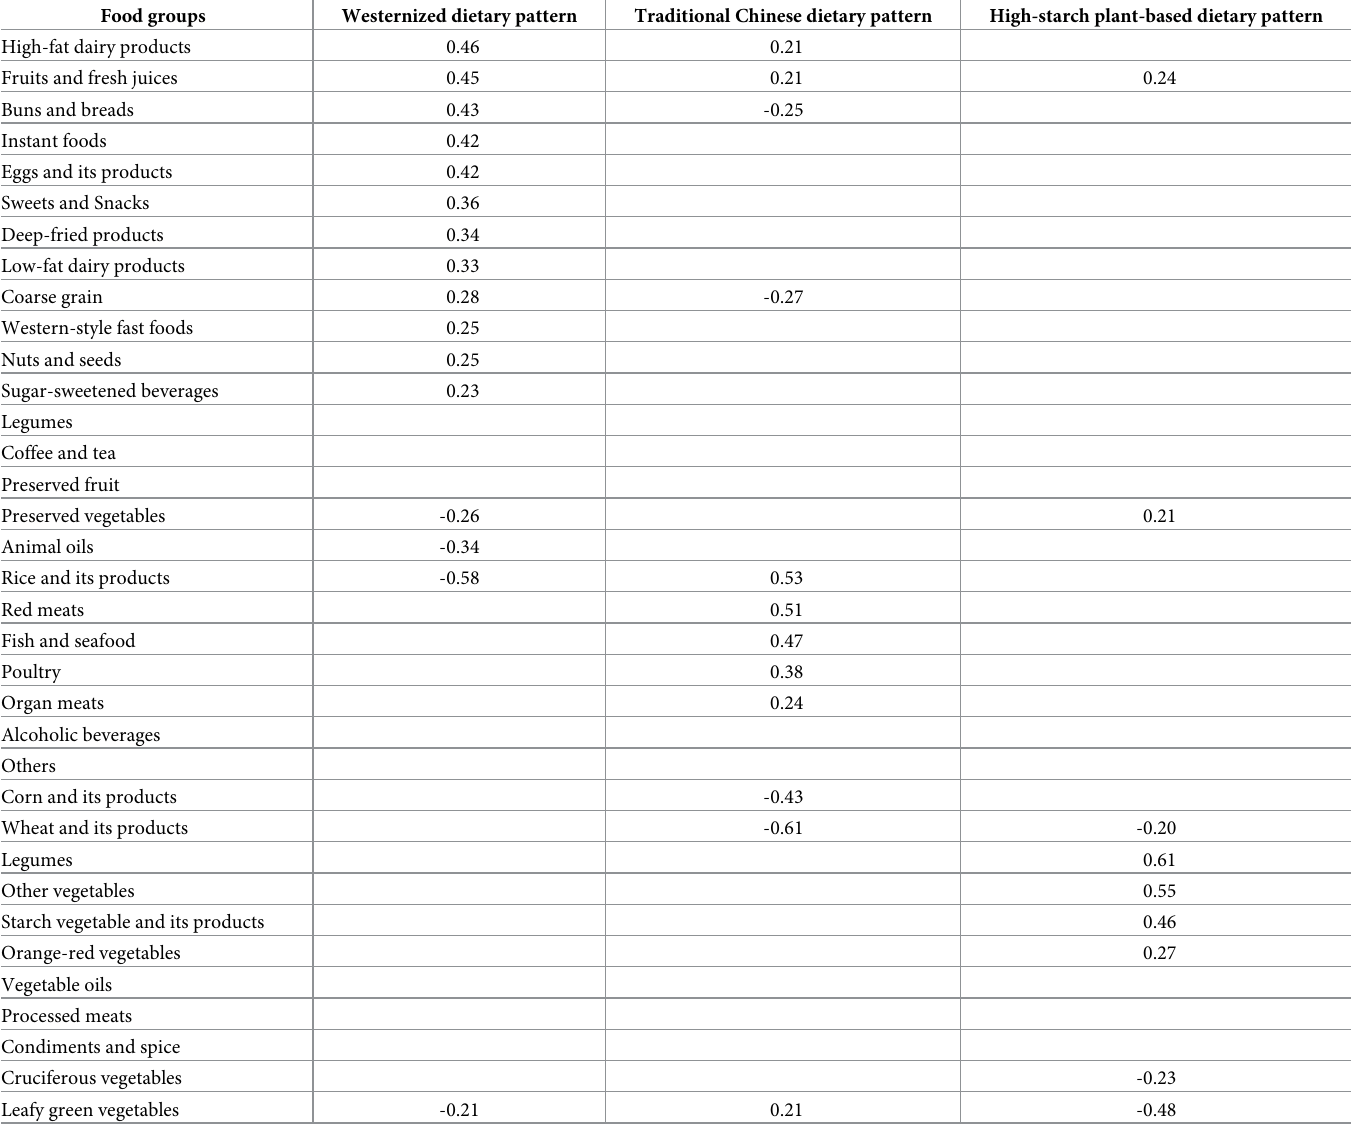
Table 1. Factor loadings a for food groups of the three dietary patterns identified (n =